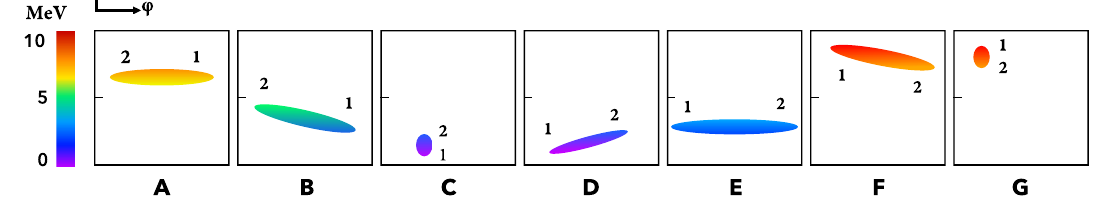
FIG. 5. Sketches of the changes in the electron beam phase space ( E − ϕ ) in the deep overcompression scheme at different positions along the beam line, where positions A – G correspond to points A – G on the red curve in Fig. 4.